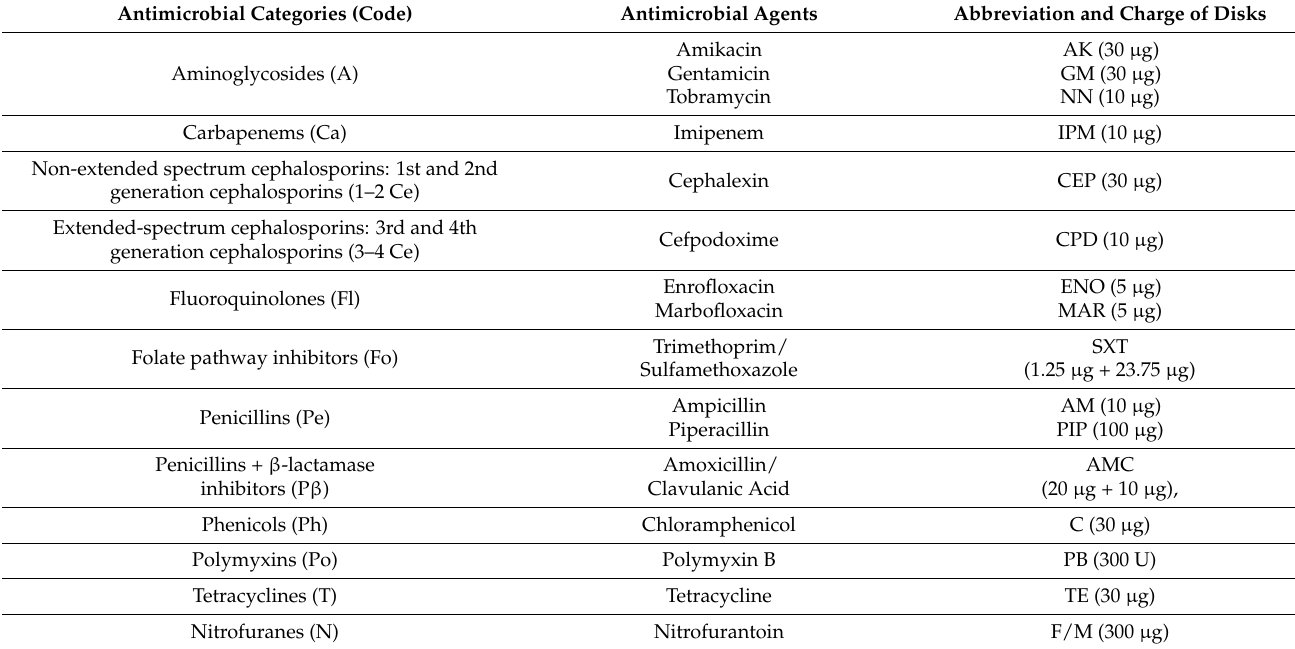
Table 1. Antimicrobial categories and antimicrobial agents tested for defining MDR in E. coli isolates (adapted from Magiorakos et al. 2012). Antimicrobial Categories (Code) Antimicrobial Agents Abbreviation and Charge of